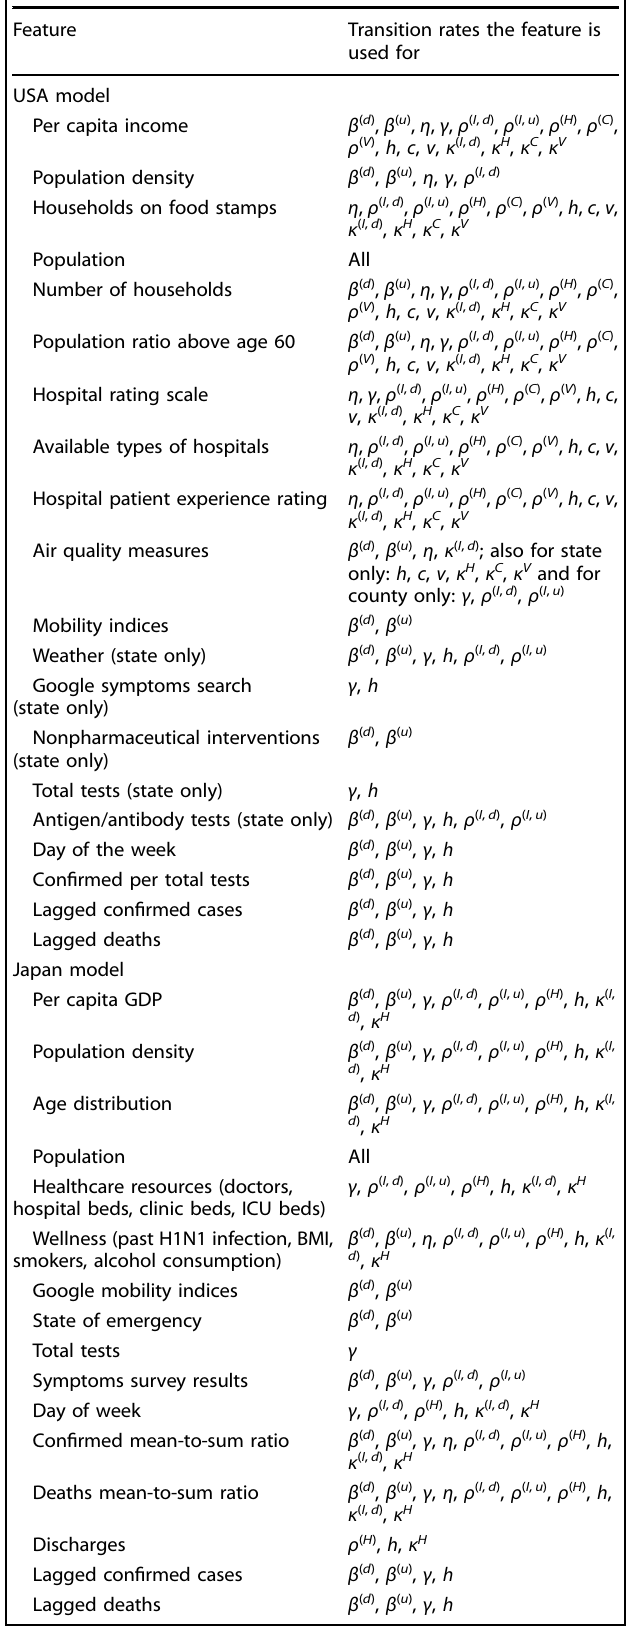
Table 2. Features used by the USA and Japan models. Feature Transition rates the feature is used